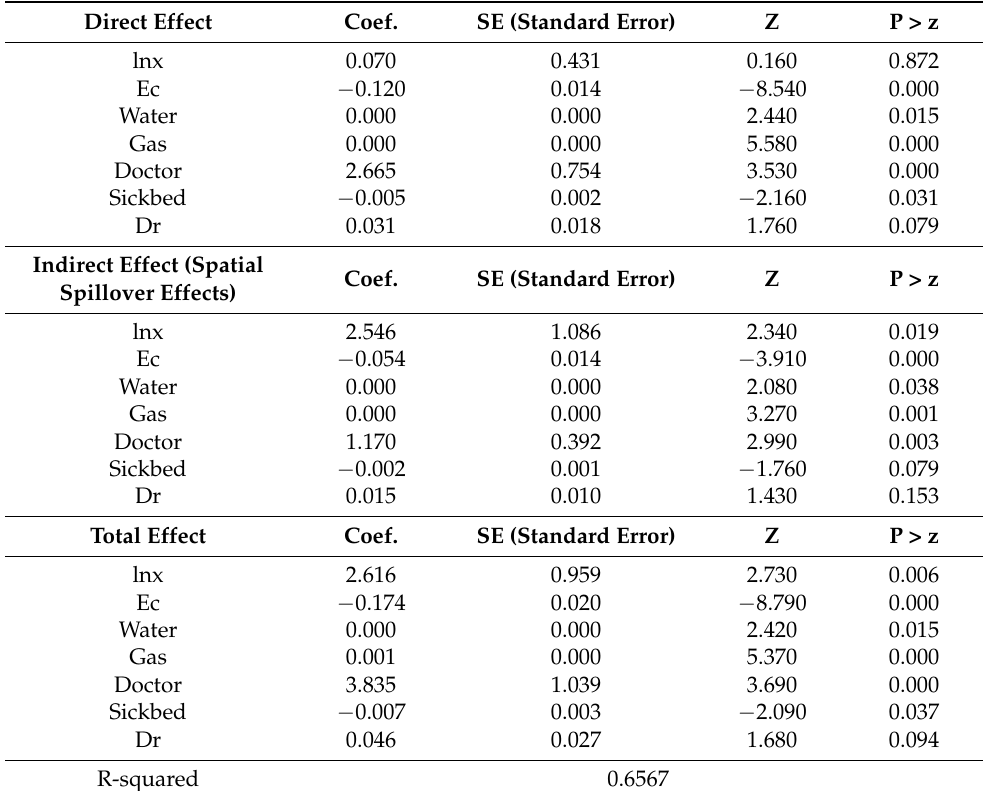
Table 4. Regression results of spatial Durbin